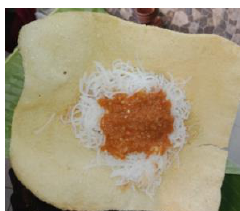
Figure 16. Belinjo Crackers